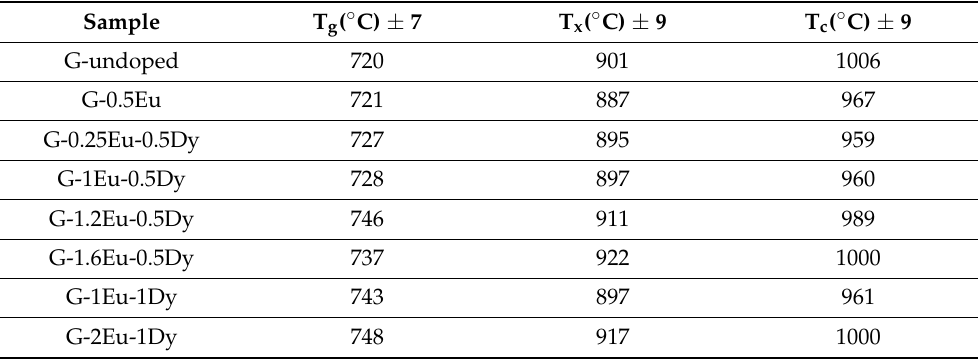
Table 4. Sintering and flow temperatures of glass (ø <20 μ m) samples determined with HSM. Sample